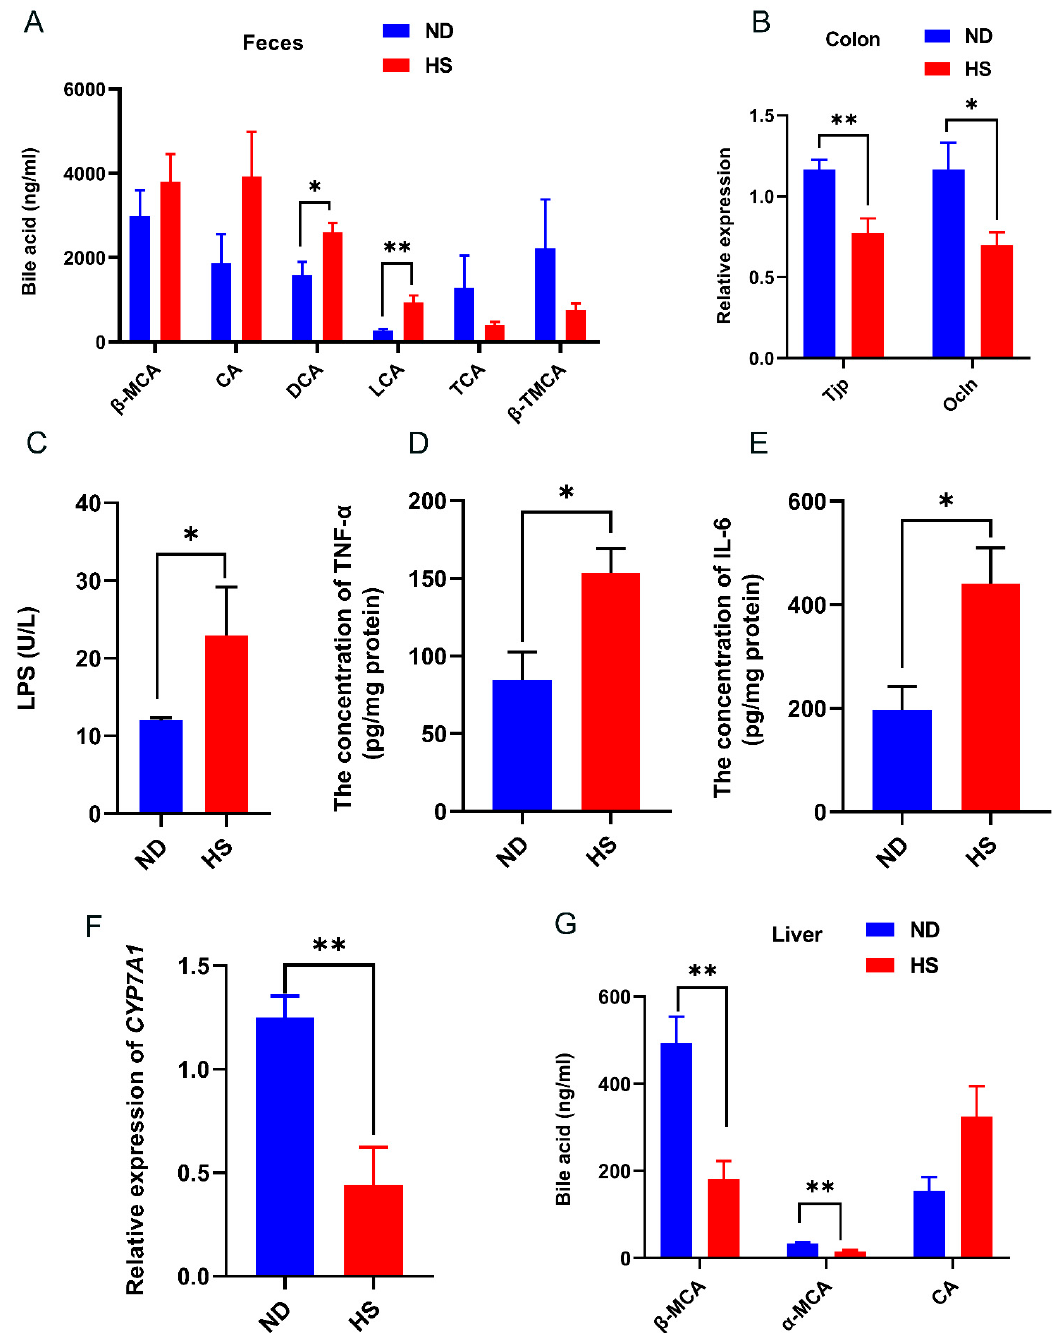
Figure 4. Effect of perinatal high-salt (HS) diet on offspring bile acid and gut permeability. ( A ) Levels of bile acid in feces. ( B ) Relative mRNA expression of tight junction protein ( Tjp ) and occludin ( Ocln ) in the colon, normalized to Gapdh . ( C ) Plasma concentration of endotoxin (LPS). ( D , E ) Levels of TNF- α and IL-6. ( F ) Relative mRNA expression of CYP7A1 in the liver, normalized to Gapdh . * indicates p < 0.05; ** p < 0.01. ( G ) Levels of bile acid in liver. Note: ND, normal diet; α -MCA, α -muricholic acid; β -MCA, β -muricholic acid; DCA, deoxycholic acid; LCA, lithocholic acid; TCA, taurocholic acid; β -TMCA, taurosulfur- β -rocholic acid.